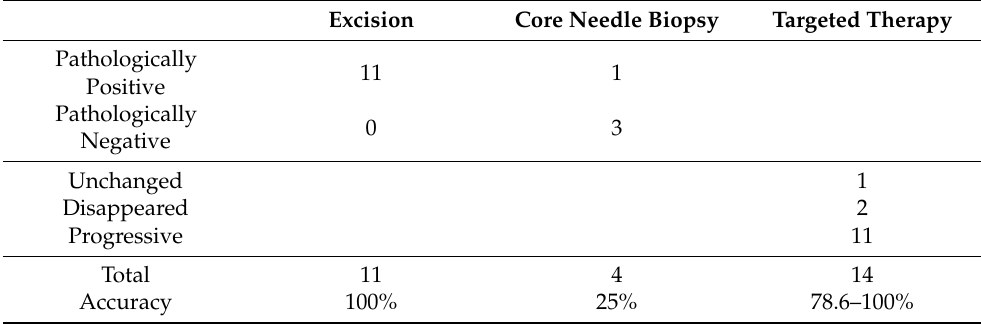
Table 6. Management and outcome of metastatic pulmonary nodules.